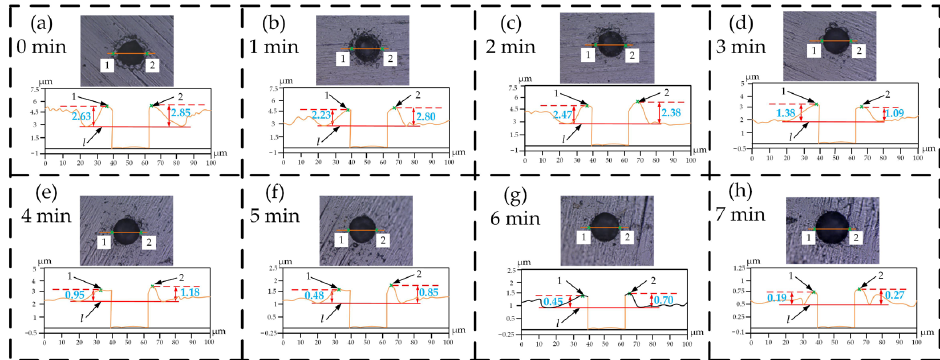
Figure 4. Burr height of metal sheet: ( a ) Untreated sheet; ( b ) Sheet treated for 1 min; ( c ) Sheet treated for 2 min; ( d ) Sheet treated for 3 min; ( e ) Sheet treated for 4 min; ( f ) Sheet treated for 5 min; ( g ) Sheet treated for 6 min; ( h ) Sheet treated for 7 min.